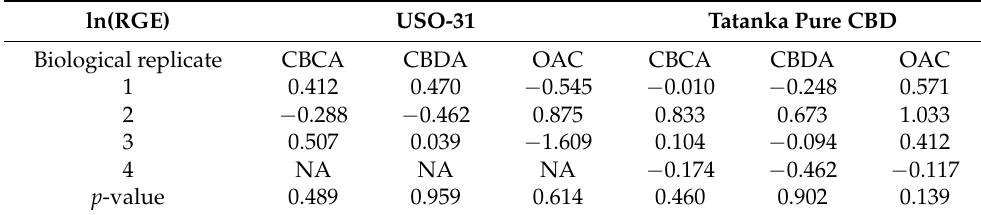
Figure 4. Bar plots show mean values of the given RGEs ( CBDAS , CBCAS , and OAC ) of the experi- mental variant Cannabis sativa ‘USO 31’ (without the outliers) and ‘Tatanka Pure CBD’ cultivars. The points represent the concrete values. Expression data were normalised using Act as a housekeeping gene, and the experimental variant was calibrated relative to the control variant (RGEs of the control variants = 1). No statistically significant differences (at statistical significance level α = 0.05) were found between the analysed variants. Table 1. Results from the t -test applied on RGE for both cultivars.